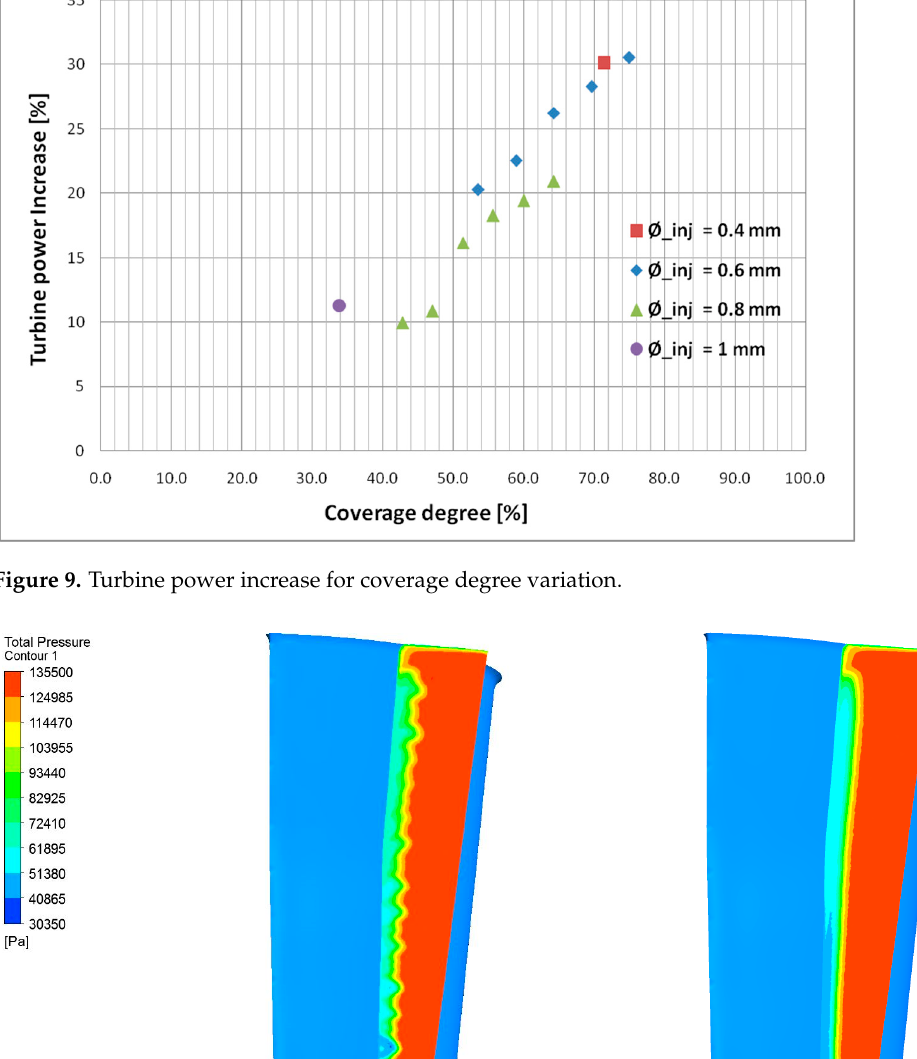
Table 5. Partial regimes